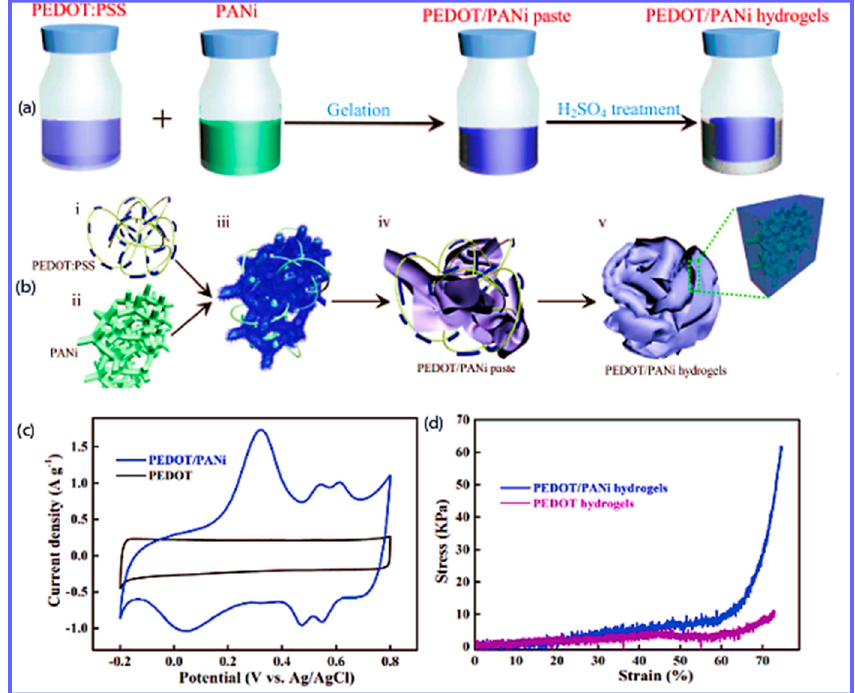
Figure 17. Graphical presentation of PEDOT/PANI hydrogels fabrication through two-step mechanism( a ), Graphical presentation of the formation process of the PEDOT/PANI hydrogels. ( b ) The comparative CVs of PEDOT and PEDOT/PANI at 5 mV.s − 1 . ( c ), Compressive stress-strain curve of PEDOT/PANI hydrogels. ( d ) Reprinted with permission from [352], Copyright 2020, American Chemical Society.